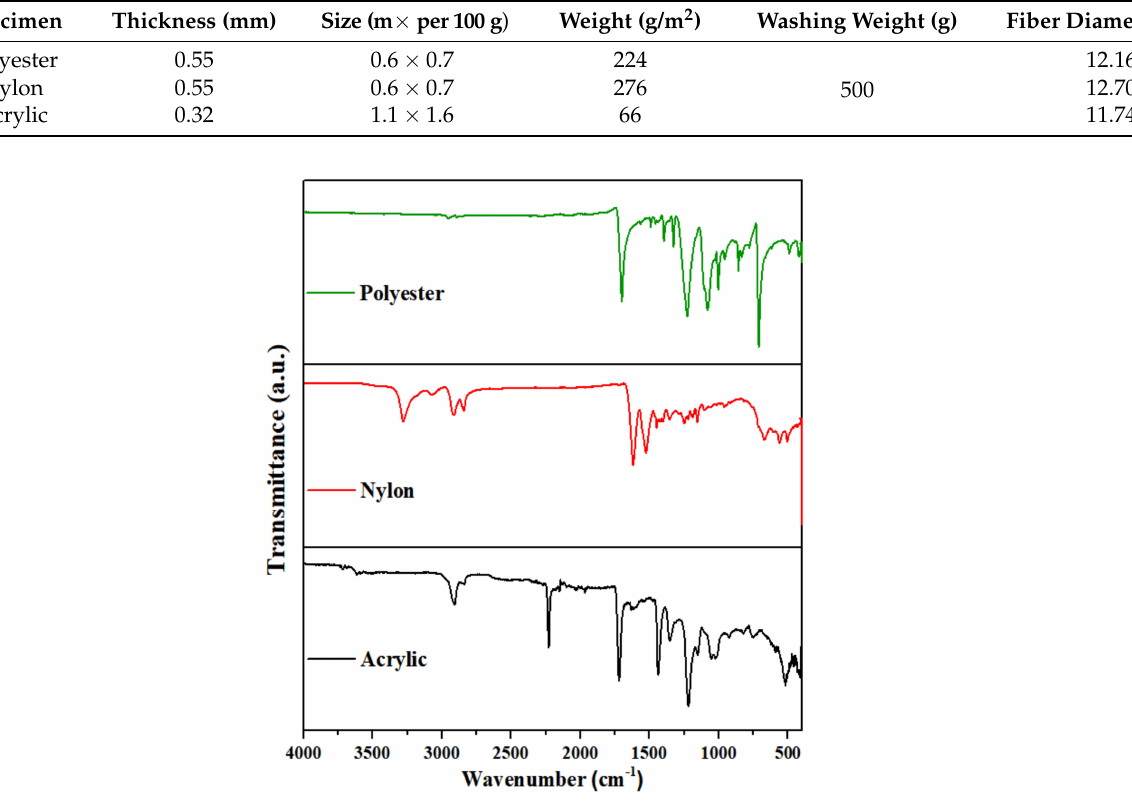
Figure 2. FTIR spectra of the three fabric